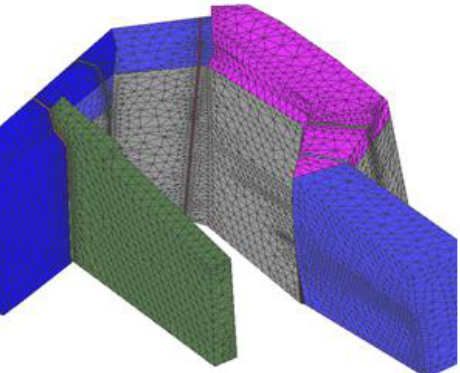
Figure 20. The finite element model of the investigated tower, where different colours correspond to areas where different material properties were assigned (see Figure 21).